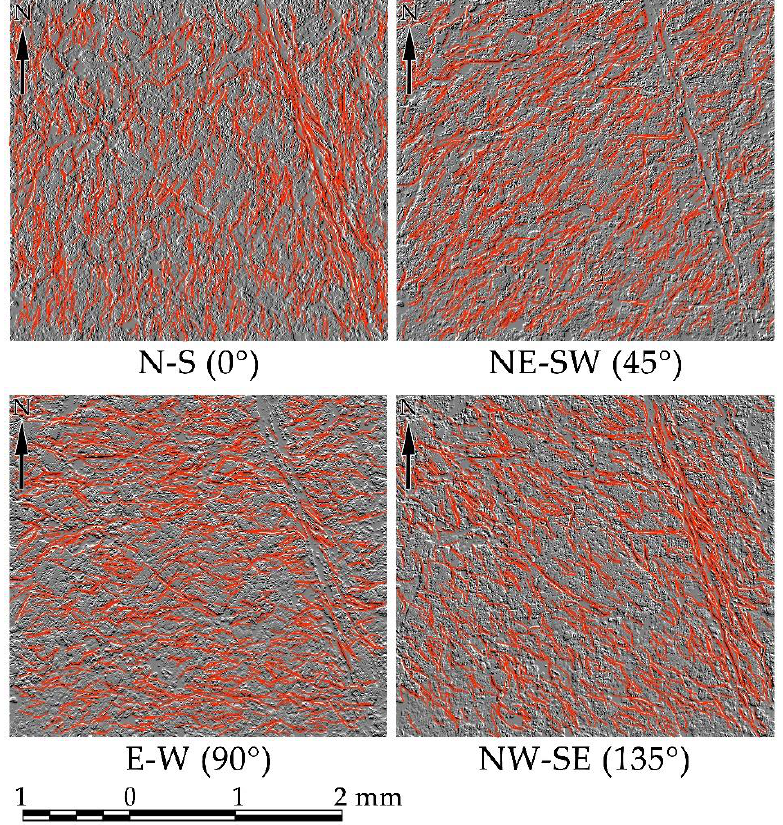
Figure 5. The result of detecting microfractures (red lines) by the LINE module in the PCI Geomatica according to the verified parameters of the part of the filtered image of the oriented thin section in four principal directions.